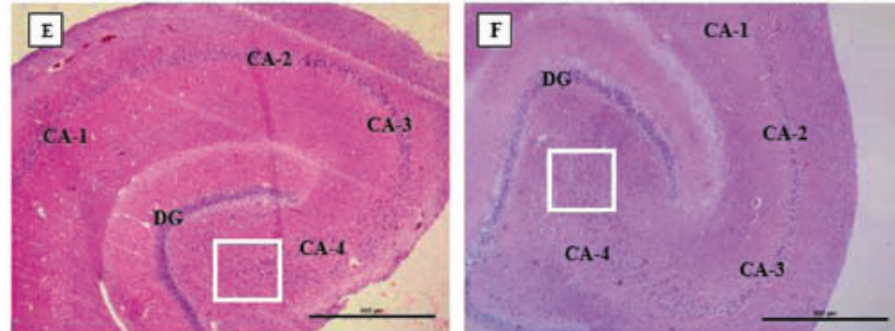
Figure 2. Hippocampus of a younger and older dog: E. Densely packed neurons, 4.5 months old dog, (Case No. 59/21). F. Reduced number of neurons, 11 years old dog, (Case No. 57/21 ). DG- Dentate Gyrus, CA- Cornu Ammonis, highlighted square- Hilus, where the number of neurons were counted. E & F . 100X.